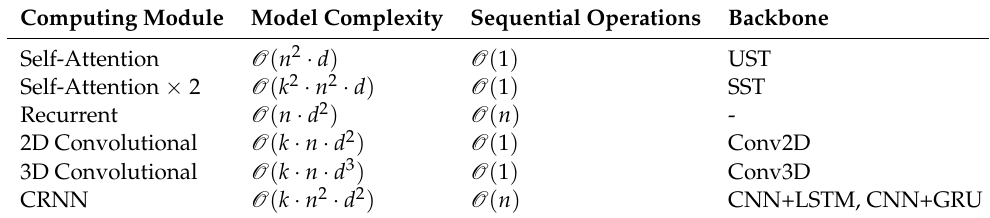
Table 9. Model complexity of the core computing module for the six backbones.